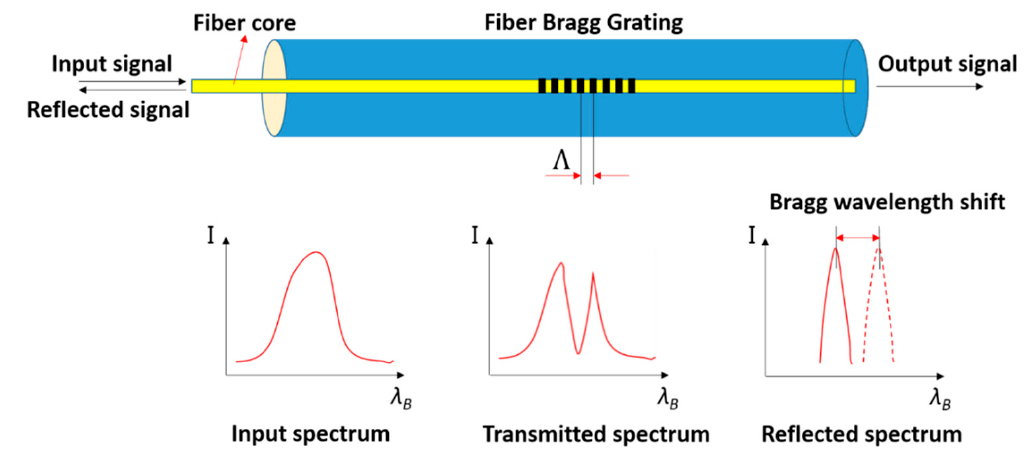
Figure 1. Schematic diagram of a fiber Bragg grating (FBG) sensor.